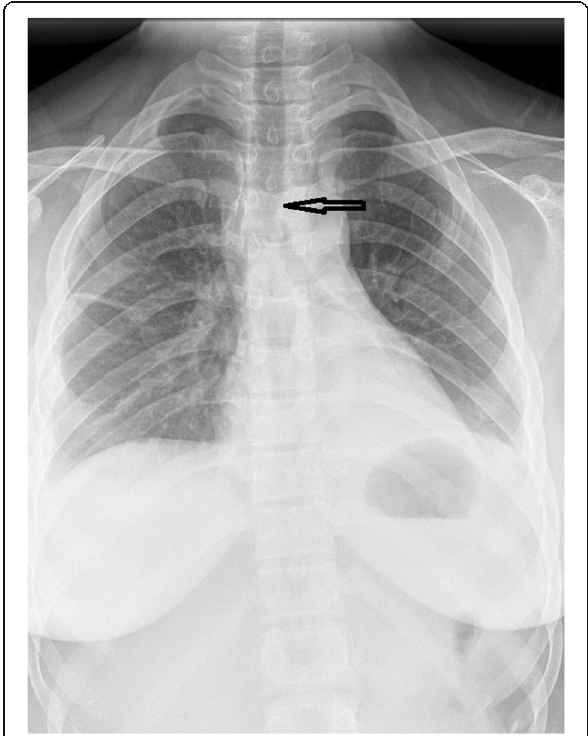
Fig. 5 Chest X-ray showing normal post-operative change in trachea (black arrow) with no lung